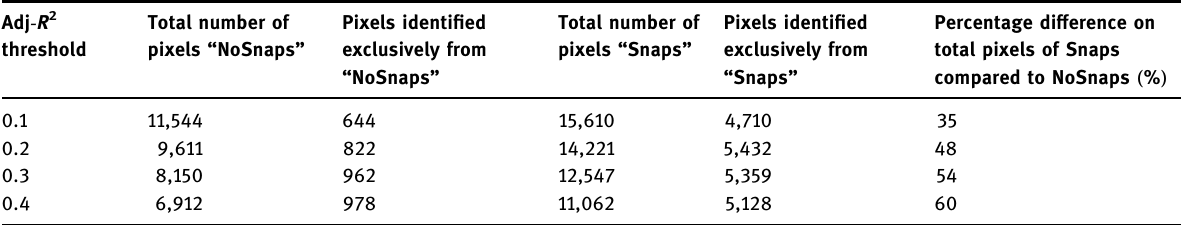
Table 2: Pixel contribution for every protocol after thresholding Adj - R 2